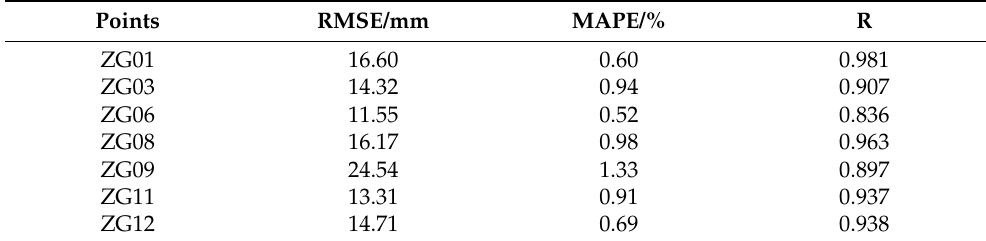
Table 4. The cumulative displacement prediction